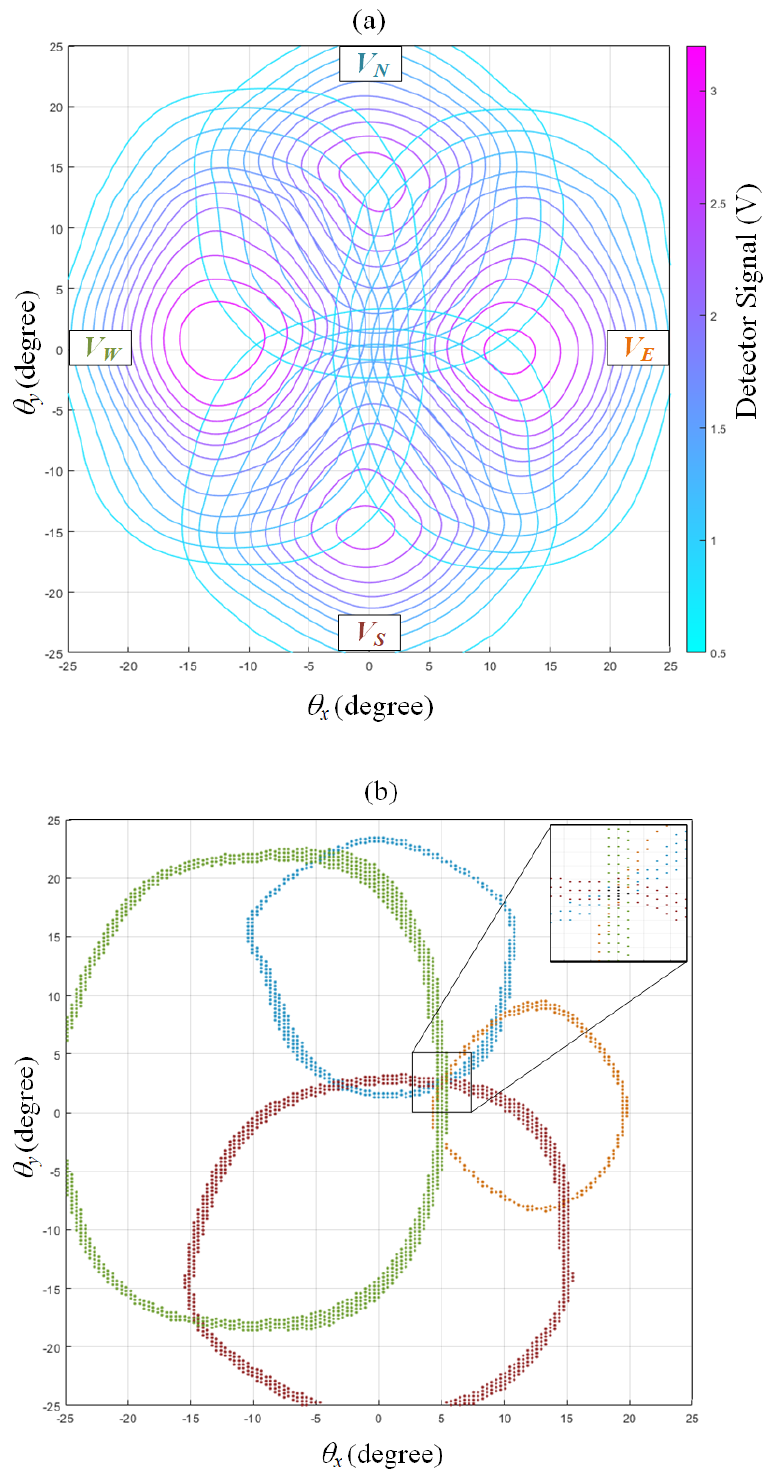
Figure 9. ( a ) Four bell-shaped signals pre-collected by our proposed sensor. ( b ) For a realistic measurement with noise, V E , V W , V N , V S are inversely mapped to four hoops. Orange, green, blue, and red dots represent the candidates, projected from V E , V W , V N , V S , respectively. Black dots represent their intersection, as shown in the zoomed region.